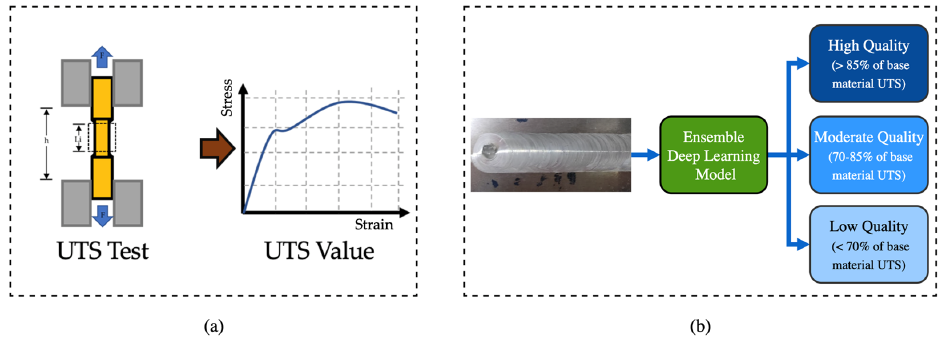
Figure 1. ( a ) Traditional UTS testing method, ( b ) UTS testing using the proposed model.